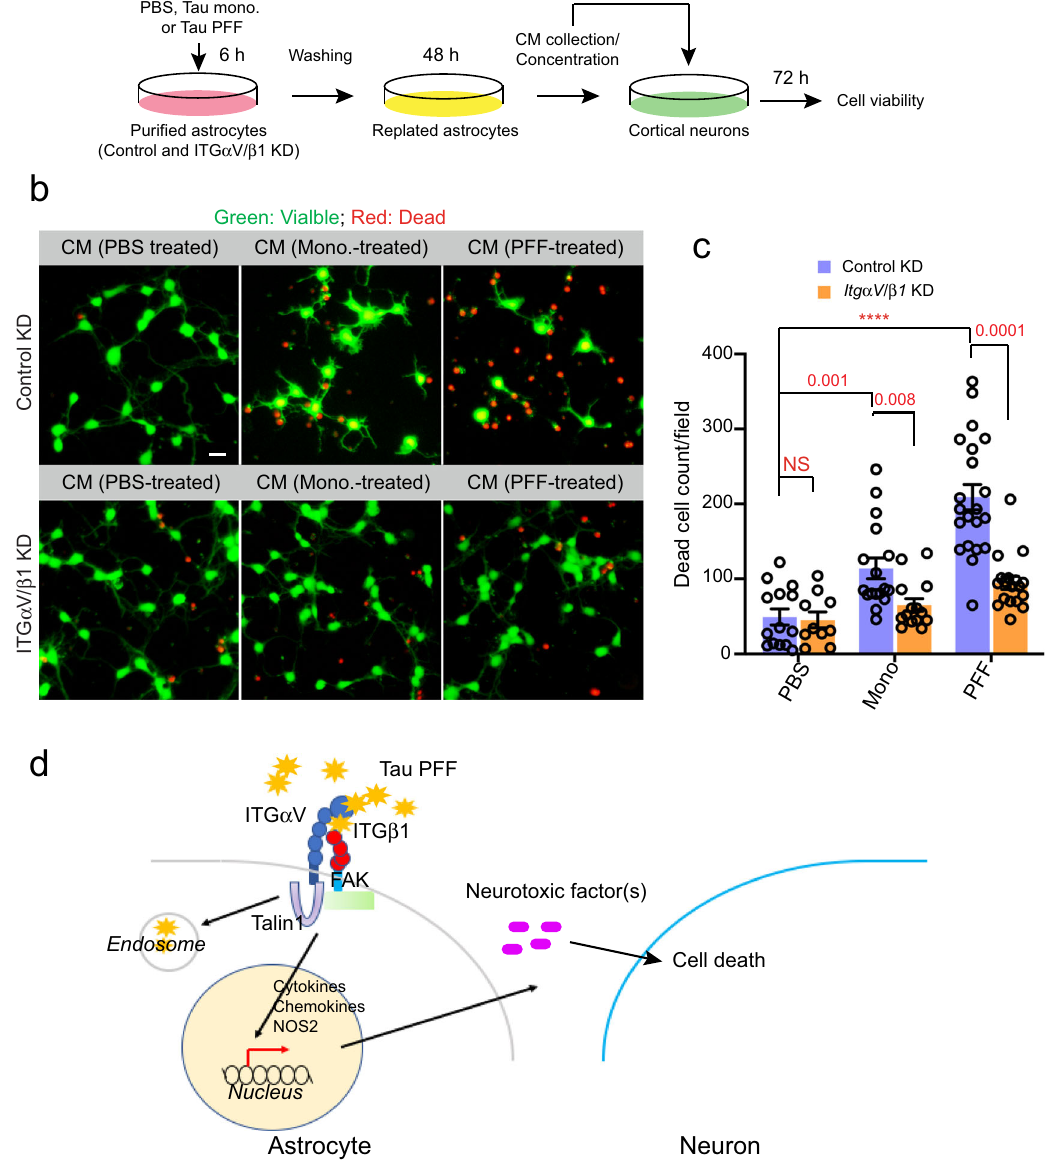
Fig. 7 Tau PFF-treated astrocytes release a neurotoxic factor(s) via ITG α V/ β 1 activation. a Scheme of the cell toxicity assay. b , c Primary cortical neurons at DIV 10 were treated with the indicated condition medium (CM) for 72 h and stained with a green- fl uorescent dye calcein-AM to label viable cells and a red- fl uorescent dye ethidium homodimer-1 to label dead cells. b Representative images. Scale bar, 10 μ m. c Quanti fi cation of dead cells labeled by ethidium homodimer-1 in randomly selected fi elds. Mean ± SEM, n = 3 biologically independent samples. The numbers and asterisks above indicate p value (**** p < 0.0001) determined by two-tailed unpaired t -test. d A working model showing the interplays between Tau-PFF, astrocytes and were incubated for 72h before being infected with lentivirus or other experiments. protocol ASP K117-LMB-17 approved by the NIDDK Animal Care and Use Before experiments, astrocytes were dissociated by trypsinization and then reseeded committee chaired by Dr. Constance Noguchi. Conventional primary astrocyte culture . Primary astrocyte cultures were pre- pared from cerebral cortices of P2-P5 C57BL/6J mice. Cortices were dissected, stripped of meninges, and digested with 0.25% trypsin at 37°C in Hank ’ s Balanced Salt Solution (HBSS) (Thermo Fisher) for 10min. Trypsinization was stopped by the addition of astrocyte culture medium (DMEM/ F12 50/50 (Thermo Fisher) containing 25mM glucose, 4 mM glutamine, 1mM sodium pyruvate, and 10% FBS). Single-cell suspension of the digested tissue was obtained by repeated pipetting. Cells were seeded into a 75 ml fl ask at a density of ~4 × 10 5 cells/cm 2 and cultured in astrocyte culture medium at 37 °C in a humidi fi ed 5% CO 2 incubator. Monolayers of glial cells were obtained 7 – 10 days after plating. To remove microglia, cultures were gently shaken, and the fl oating cells (microglia) were removed, resulting in more than 95% pure astrocytes. The remaining astrocytes